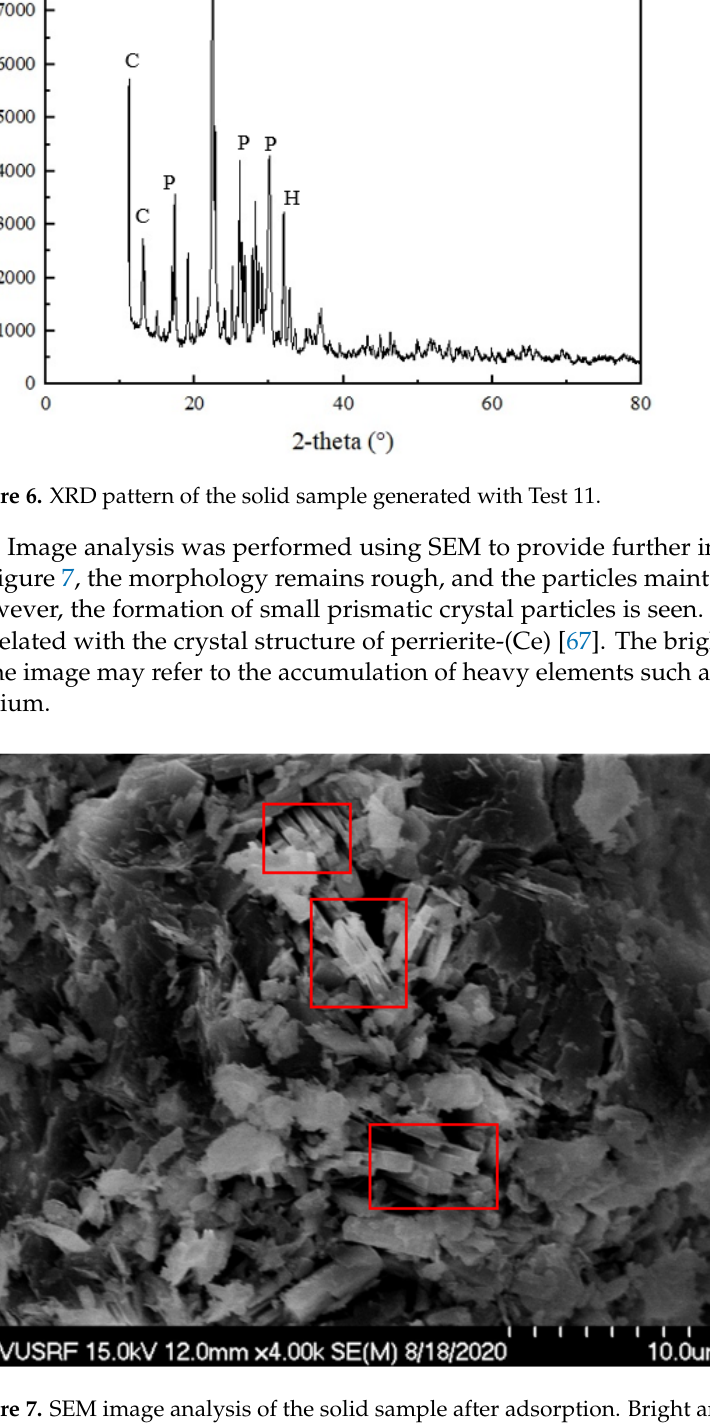
Figure 7. SEM image analysis of the solid sample after adsorption. Bright areas highlighted in the red boxes indicating the deposition of heavy elements.